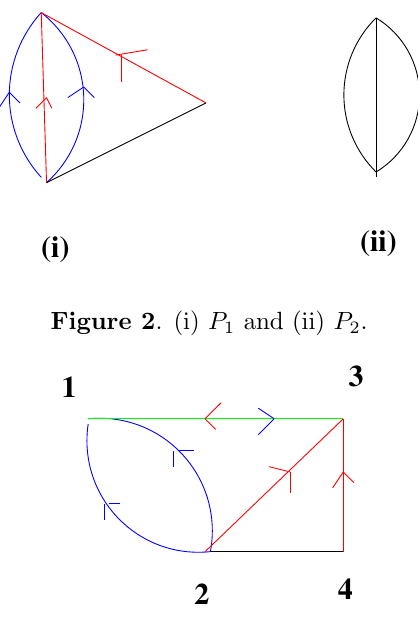
Figure 3 . The auxiliary diagram